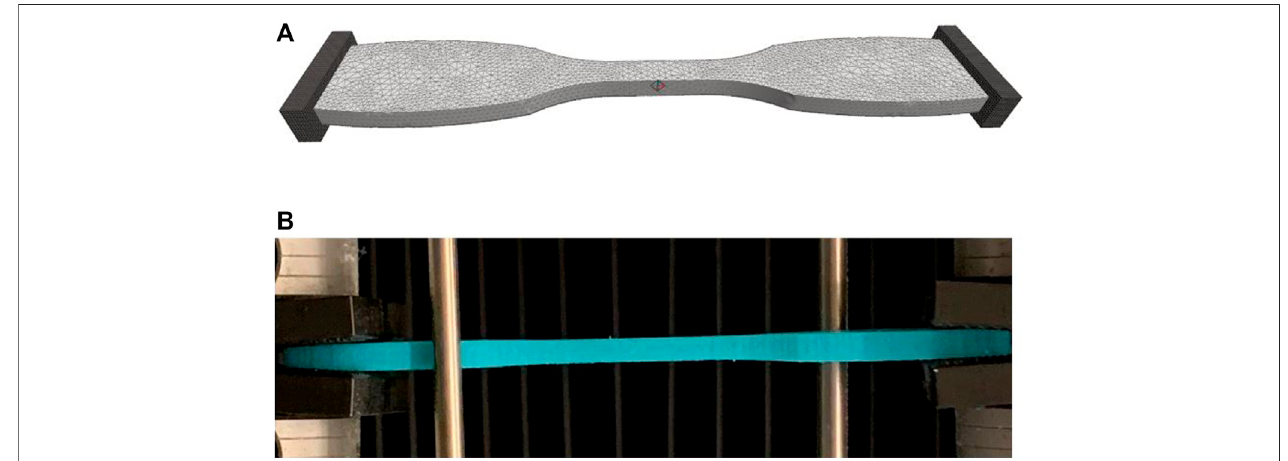
FIGURE 1 | (A) Finite element model of ASTM D638 dumbbell test specimen used to test J750 materials. (B) Actual 3D printed J750 Shore material undergoing tensile stress relaxation test in Instron. The fi nite element model was created using FEBio Preview 1.5. The model was analyzed using either FEBio 2.9.1 or FEBio 3.3.1 using the parameter optimization tool to fi t the nonlinear viscoelastic model parameters. Rigid bodies at the end of the specimen allow for tension only contact mimic specimen gripping. The right platen was displaced to match the time-displacement curve from experimental tests.